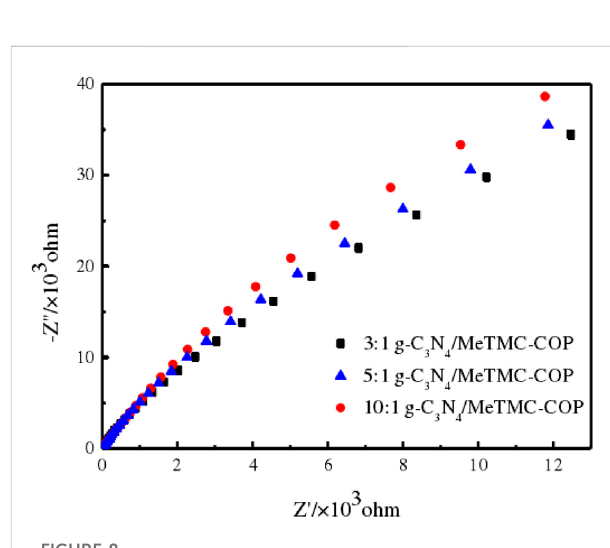
FIGURE 8 EIS spectra of different ratios of g-C 3 N 4